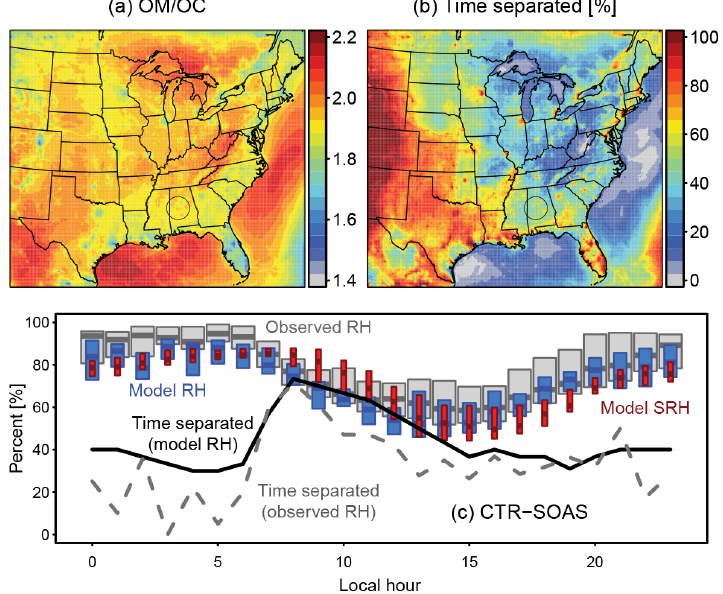
Figure 10. June 2013 mean predicted (a) OM / OC, (b) percentage of time spent separated into organic-rich and inorganic-rich phases, and (c) conditions at CTR-SOAS for the ideal W i simulation. Separation occurs when RH < SRH. Observed RH at SOAS is from the SEARCH network. Panel (c) includes a prediction of time separated using model-predicted RH (solid) and observed RH